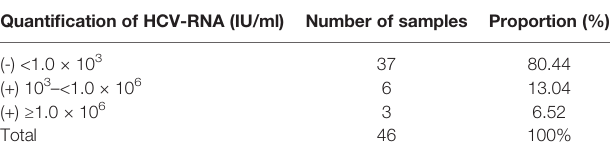
TABLE 3 | Analysis of quantitative detection results of HCV-RNA in 46 patients. Quanti fi cation of HCV-RNA (IU/ml) Number of samples Proportion (%) (-) <1.0 × 10 3